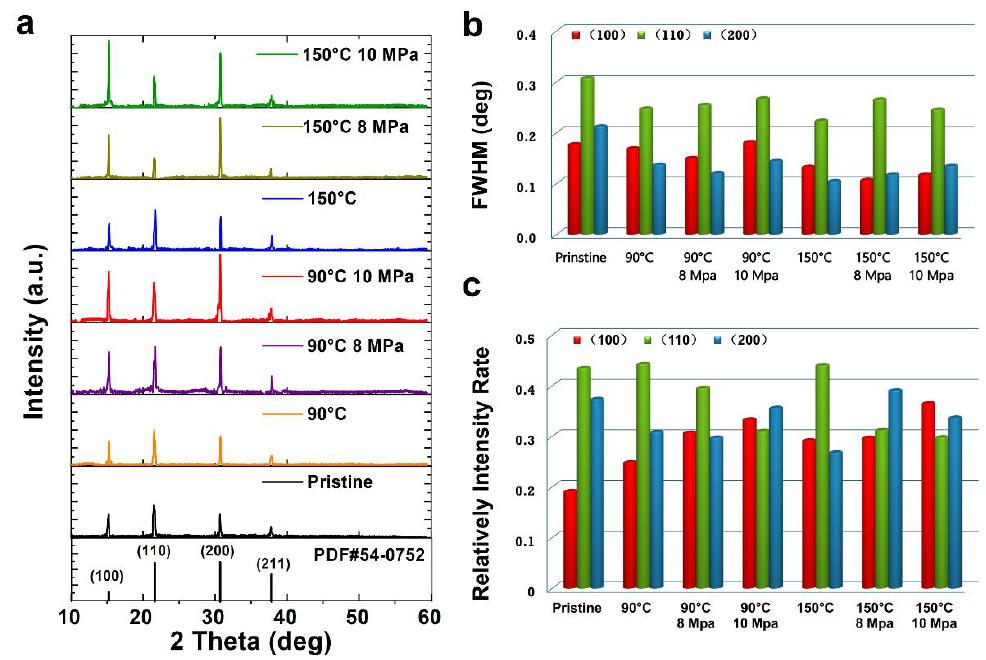
Figure 2. ( a ) XRD patterns of the pristine CsPbBr 3 film and the separated laminates prepared under different conditions, and the corresponding histograms of XRD ( b ) FWHMs and ( c ) relative peak intensities of the (100), (110), and (200) planes.